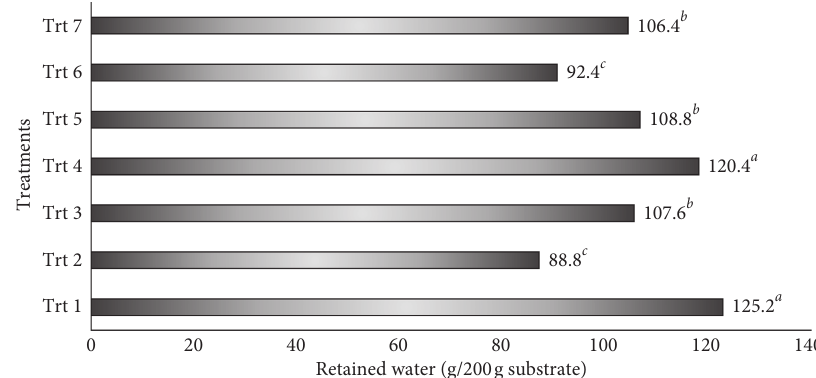
Figure 4: Graph showing the water holding capacity of the substrates used in the experiment. Table 3: The benefit-cost ratios of the substrates used in the experiment.